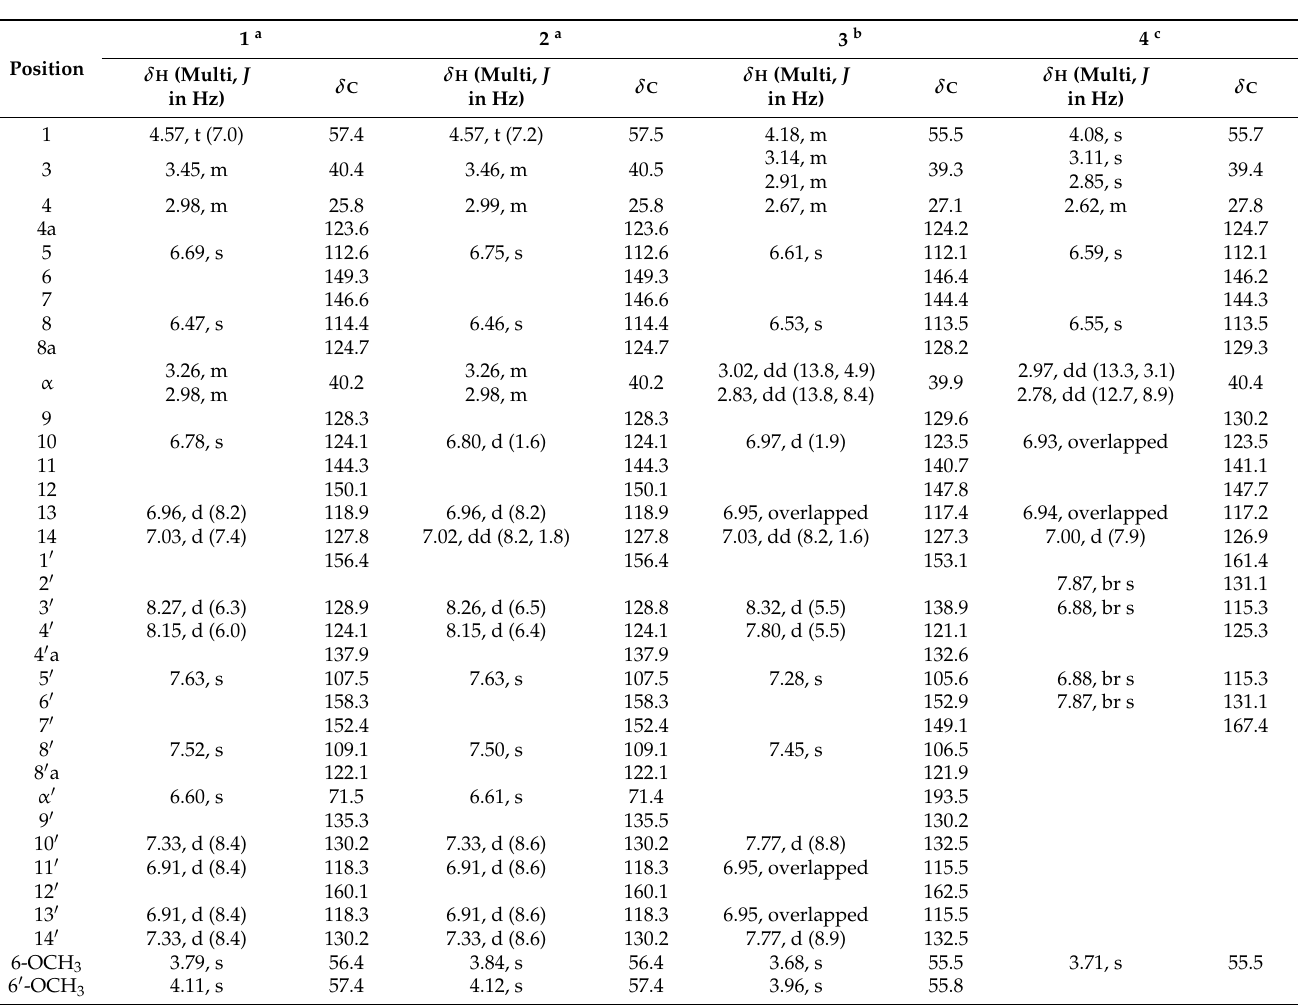
Table 1. 1 H and 13 C NMR Spectroscopic Data for Compounds 1 – 4 .